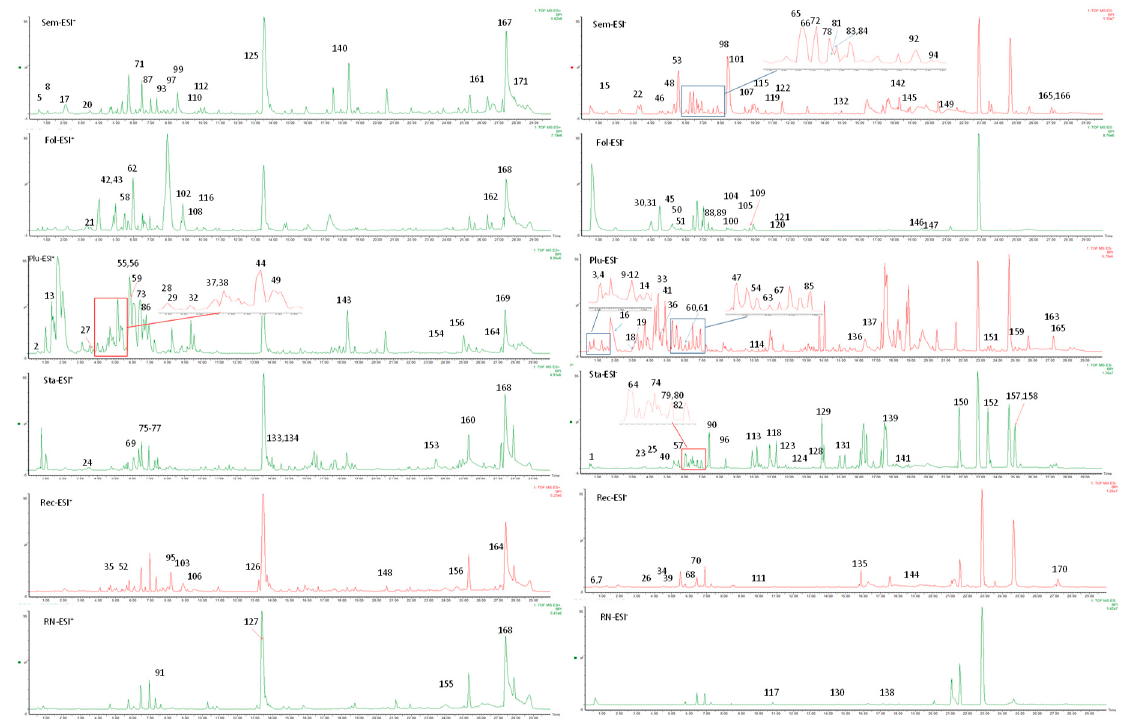
Figure 2. The representative BPI chromatograms of Sem , Fol , Plu , Sta , Rec , and RN in positive and negative